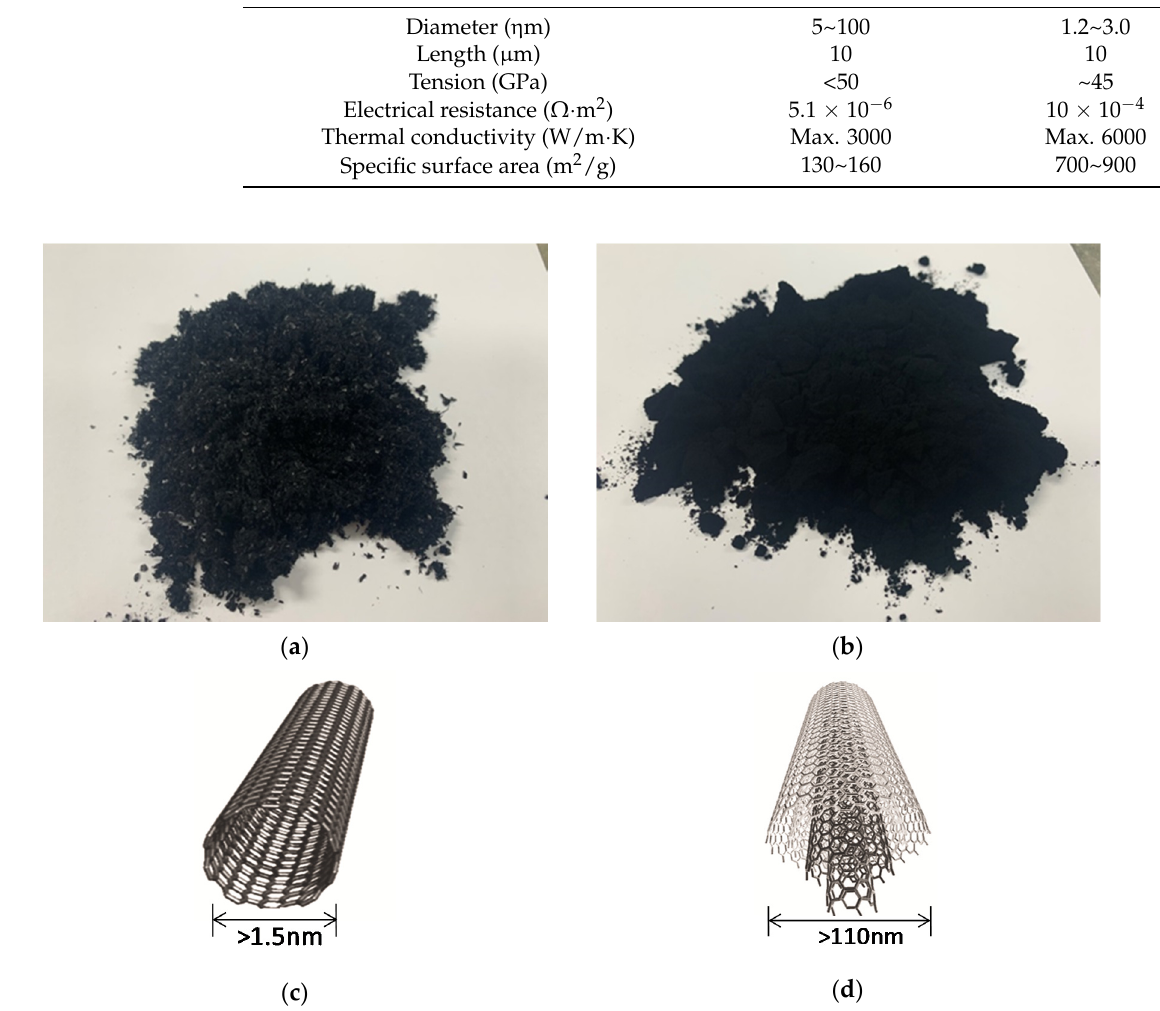
Figure 1. Picture of powder-type carbon nanotubes: ( a ) single-walled carbon nanotubes (SWCNTs); ( b ) multi-walled carbon nanotubes (MWCNTs); ( c ) schematics of SWCNTs; ( d ) Schematics of MWCNTs. Table 1. Chemical and physical properties of ordinary Portland cement (OPC). Table 3. Particle size distribution of standard sand (KS L ISO 679 [53]).